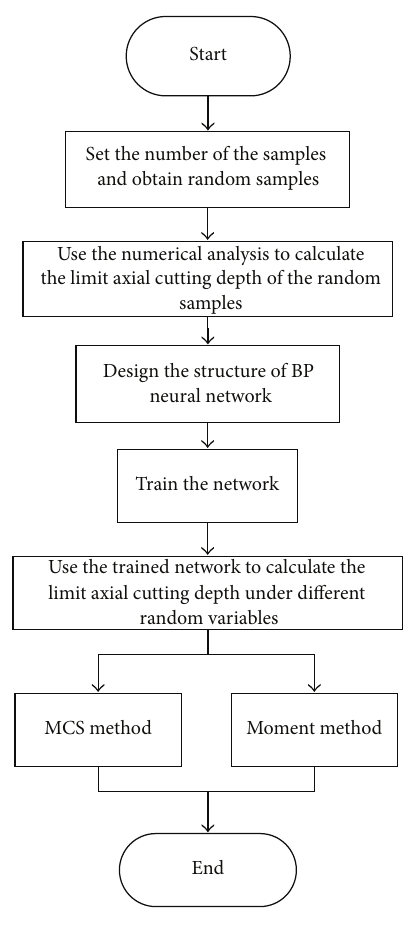
Figure 3: Flowchart for calculating the chatter stability reliability utilizing the BP neural